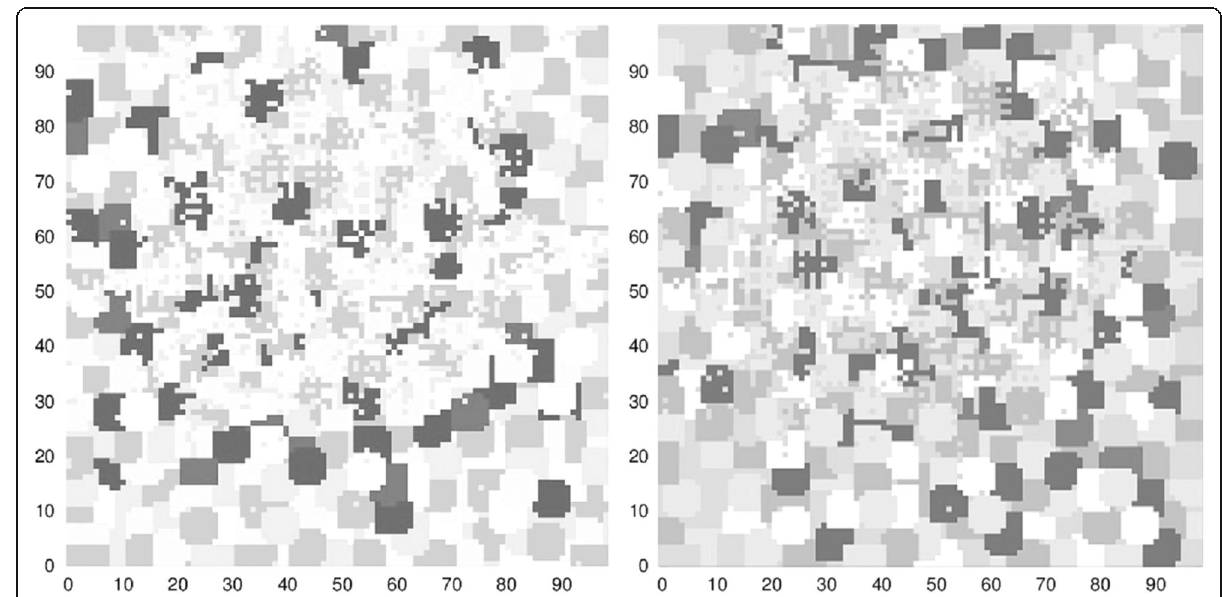
Fig. 5 The result of area recognition. The result of area recognition is shown in this figure, where each color block represents an area. In the central area of Beijing, the area is in a fine mesh shape, while the surrounding area is in a block